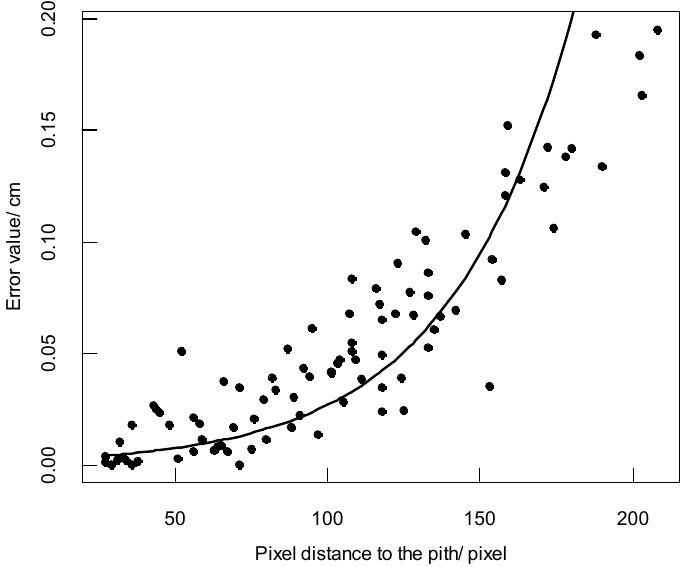
Figure 5. The fitting results of the exponential regression model.